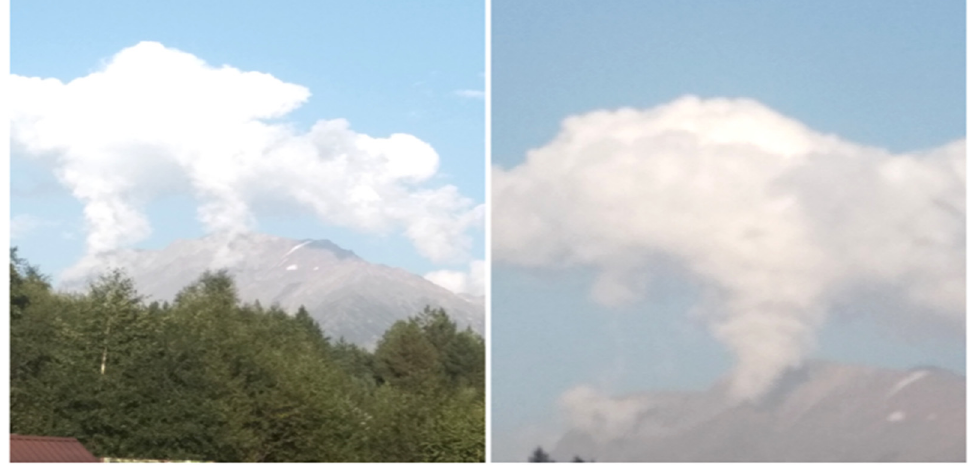
Figure 15. Example of convective clouds formed in the afternoon over the sunny mountain slope. Terskol, Northern Caucasus, Russia. 28 August 2021, time 17 36 .